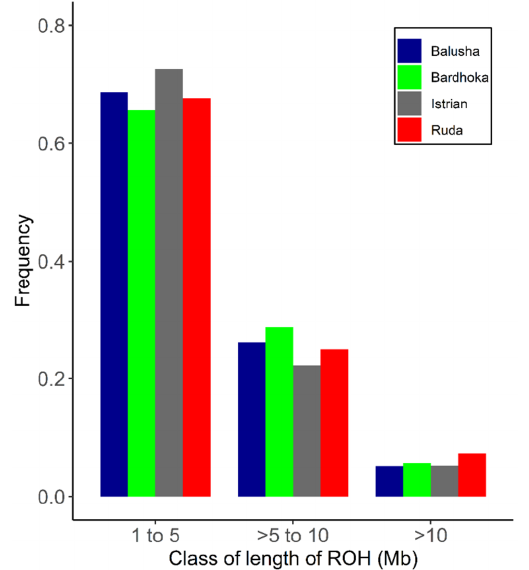
Figure 4. Frequency distribution of number of ROH in varying class lengths and for each breed. Table 2. Descriptive statistics for ROH and FROH of breeds analyzed in this study. Breed